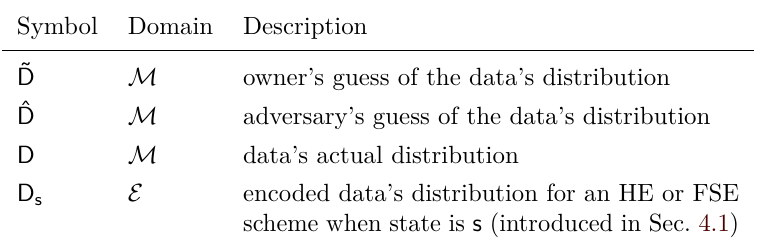
Table 1: Overview of our notation for various